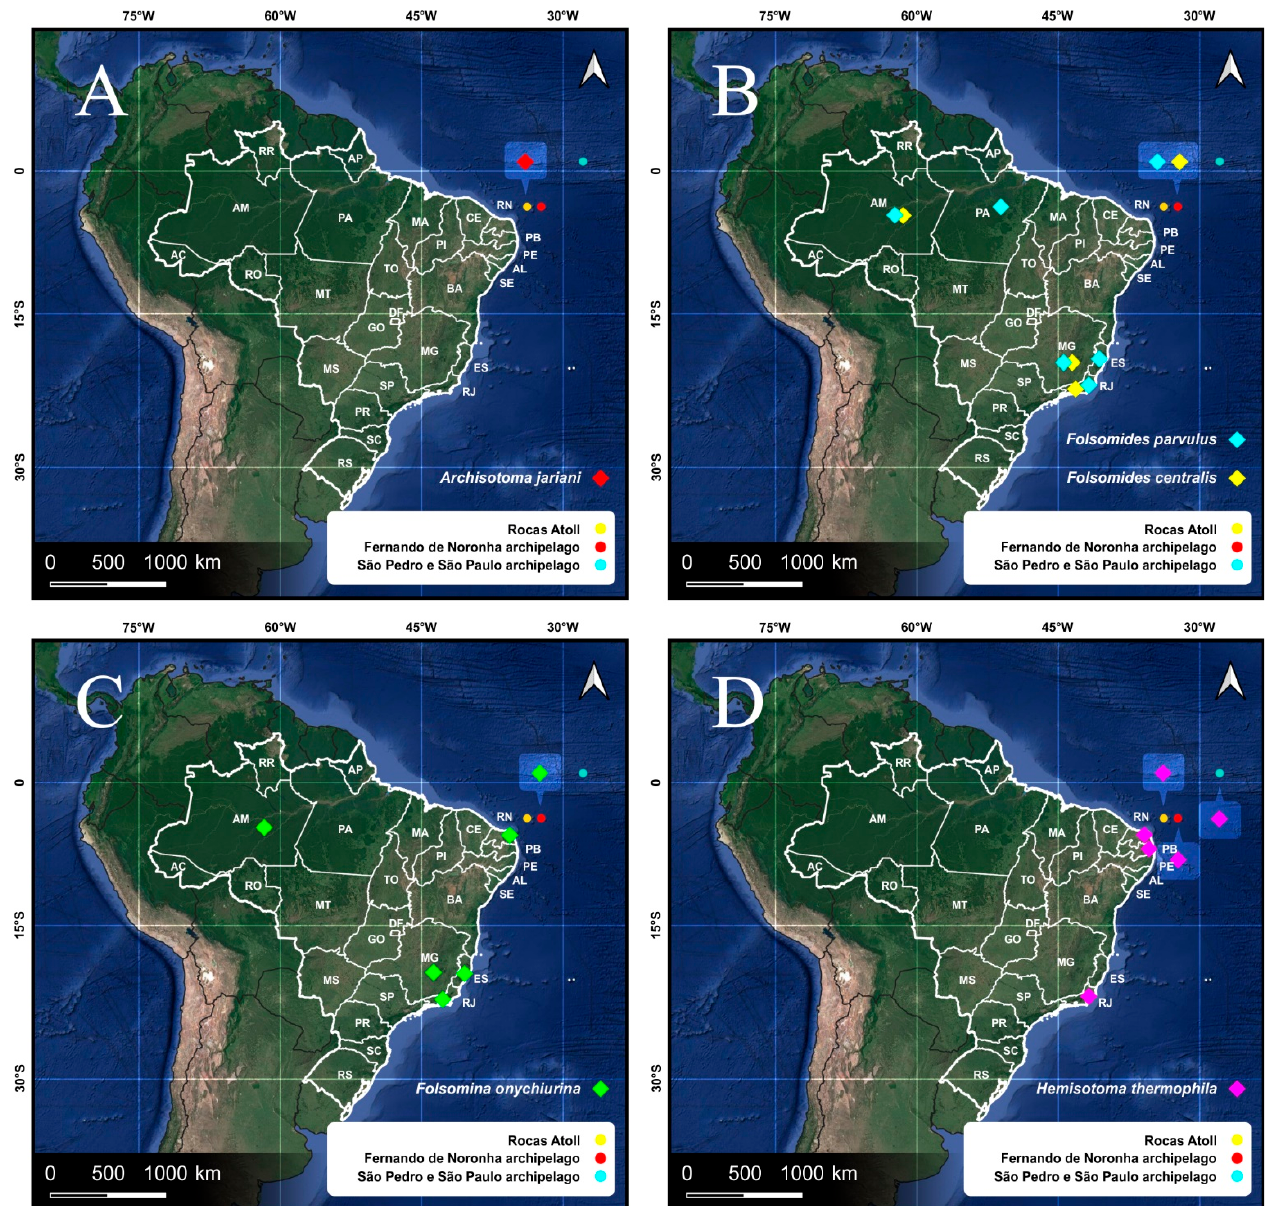
Figure 3. Distribution map for Isotomidae records in Brazil mainland and oceanic islands. ( A ). Archisotoma jariani ; ( B ). Folsomides parvulus and F. centralis ; ( C ). Folsomina onychiurina ; ( D ). Hemisotoma thermophila .